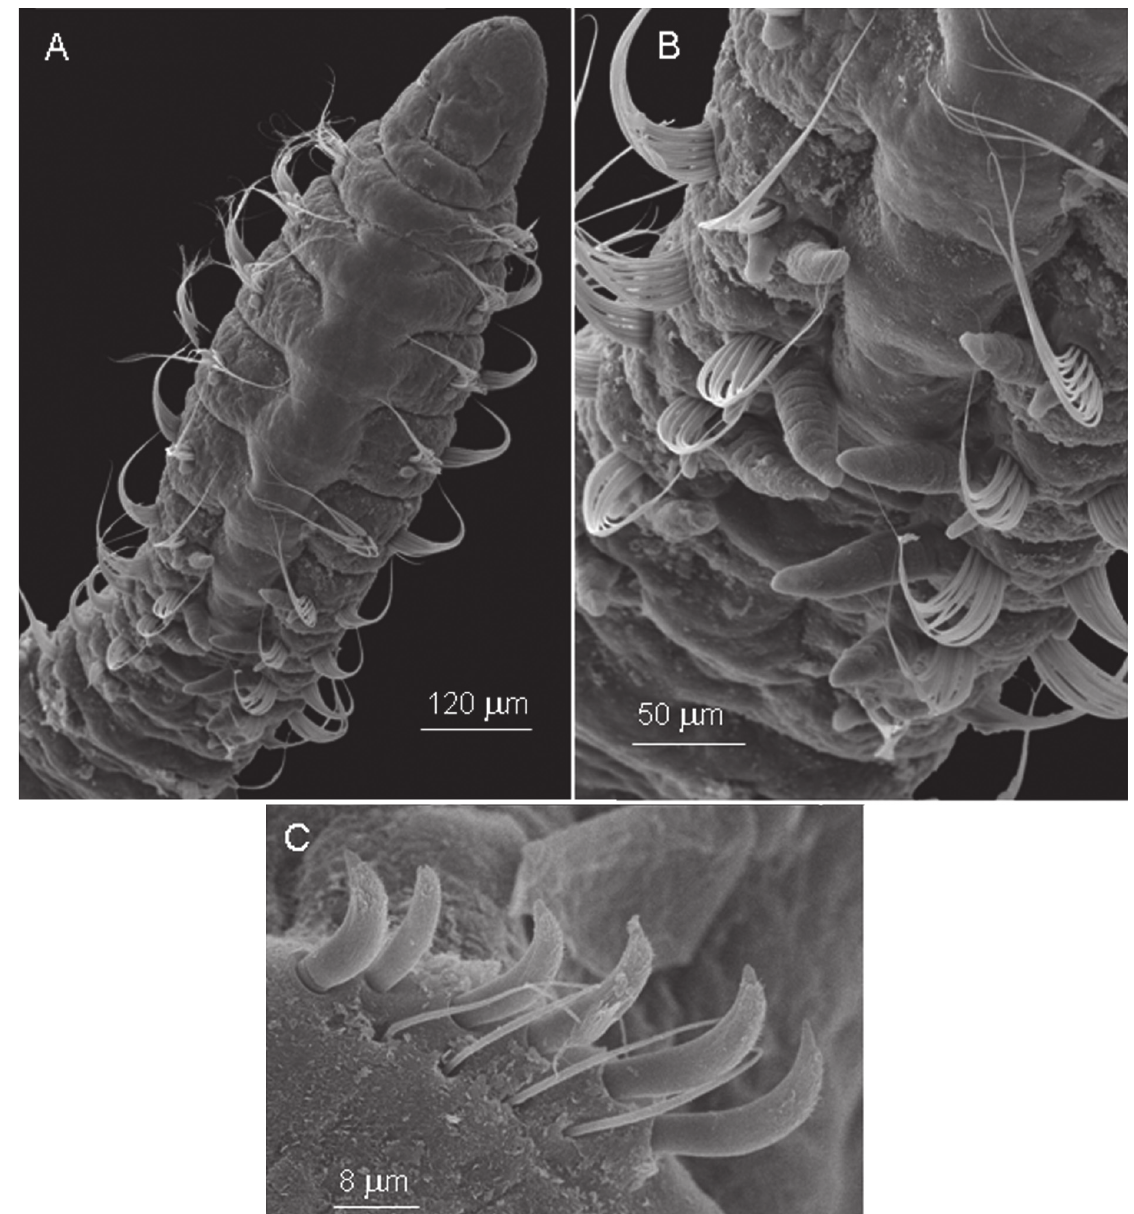
Fig . 3. – Levinsenia flava : A, anterior region, dorsal view; b, branchial region; c, modified neurochaetae. Scale bar: A 120 µ m; b 50 µ m; c 8 µ